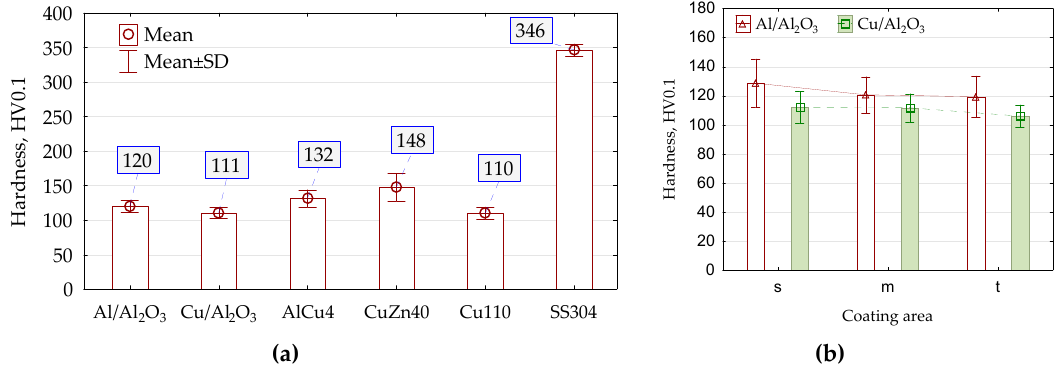
Figure 4. Adhesion of MMC coatings.